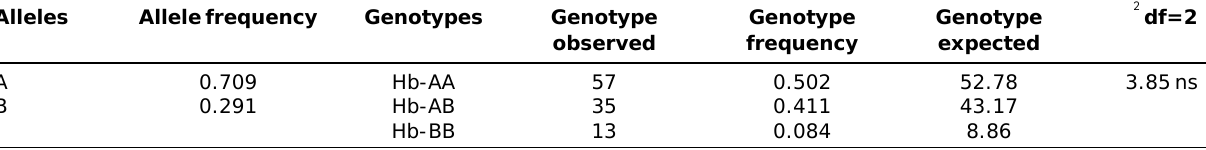
Table-1: Gene and genotypic frequency of haemoglobin in Ogaden cattle (n=105)